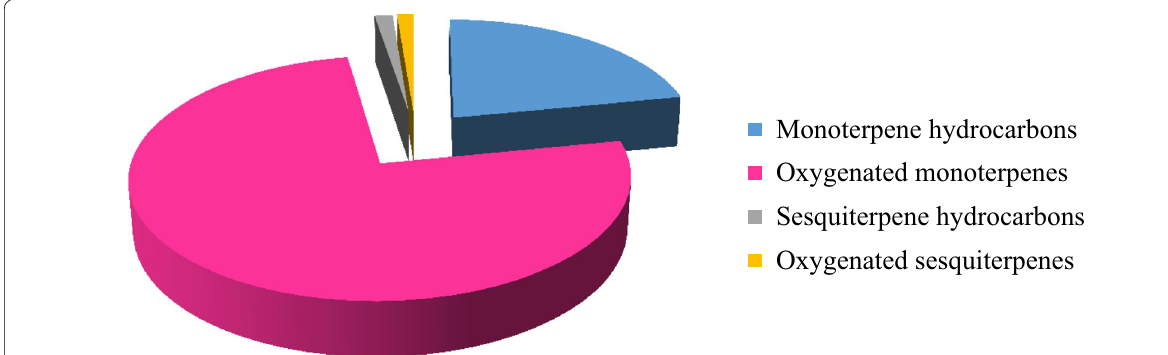
Fig. 1 Percentage distribution of classes of constituents identified in OV EO